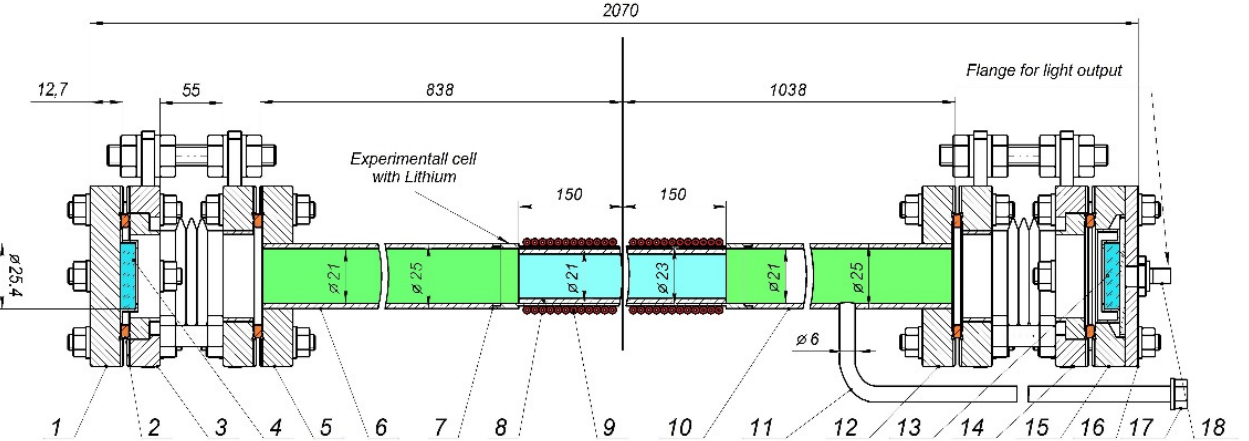
Figure 4. Experimental irradiation device, designed for in-pile experiments: 1—flange plug; 2—cop ‐ per gasket; 3—the lower aligner of ID cell; 4—silver ‐ coated mirror; 5—counter flange CF40 of the lower aligner of ID cell; 6—housing, the lower part of the experimental ID cell; 7—housing, the middle part of experimental cell; 8—lithium CPS; 9—ohmic heater; 10—housing, the upper part of experimental cell; 11—path for gas mixture supply and pumping; 12—counter flange CF40 of the upper aligner of ID cell; 13—dielectric mirror; 14—upper aligner of ID cell; 15—vacuum window with CF40 flange; 16 –flange plug; 17—nipple of KF 16 quick connection; 18—collimating lense.